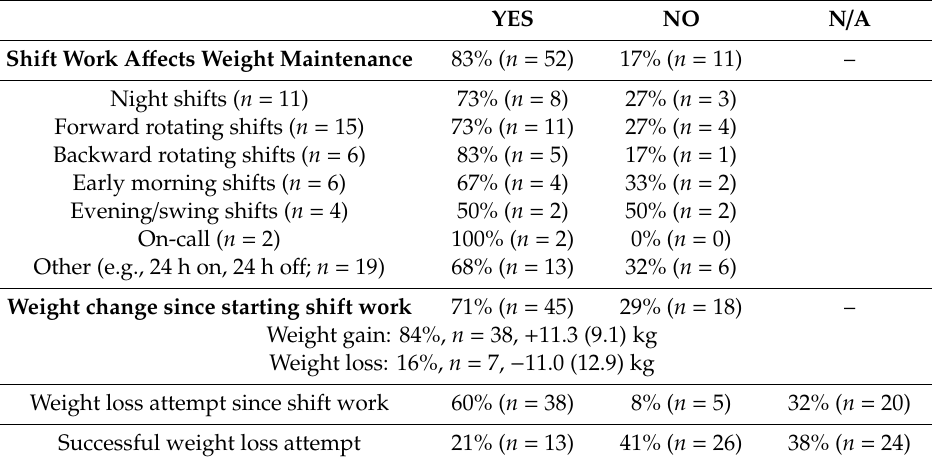
Table 2. Self-reported body weight management